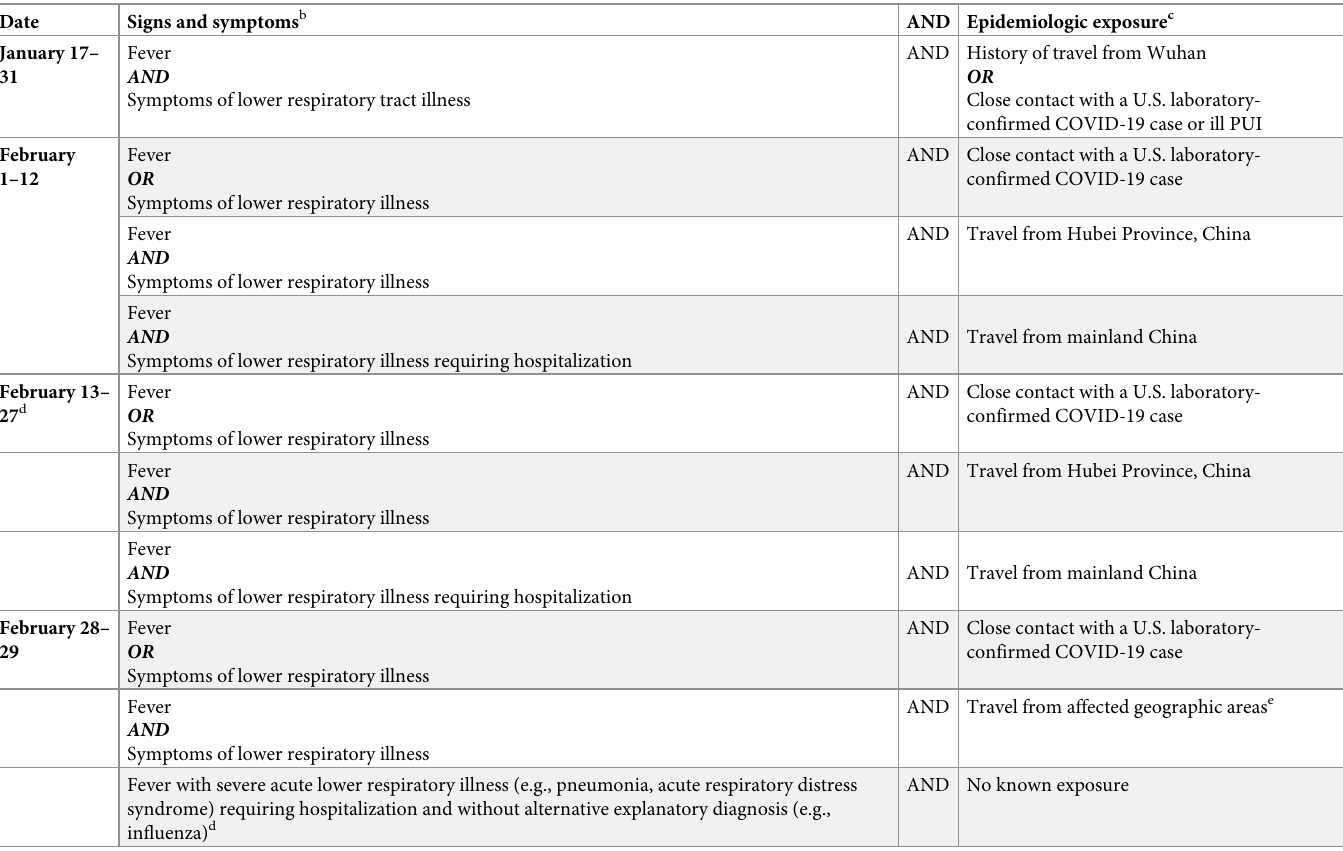
Table 1. CDC COVID-19 persons under investigation evaluation criteria, United States, January 17–February 29, 2020 a